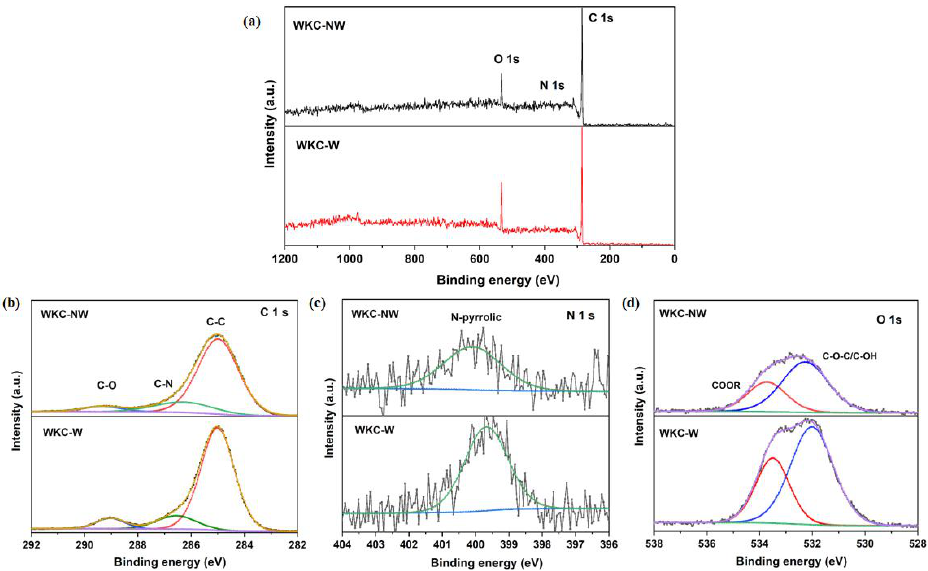
Figure 6. Survey spectra ( a ), high resolution C 1 s ( b ), N 1 s ( c ) and O 1 s ( d ) XPS spectra obtained for WKC-NW and WKC-W.